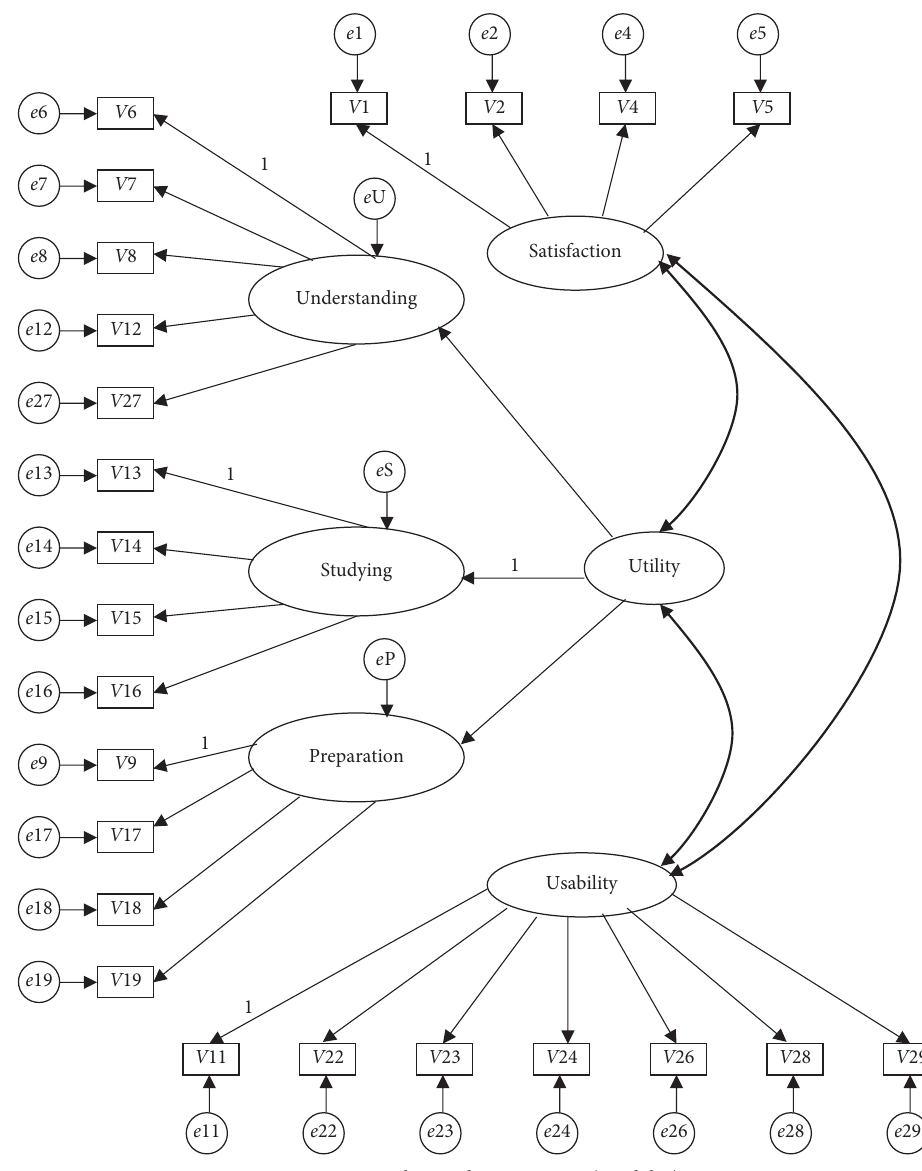
Figure 3: Higher-order construct (model